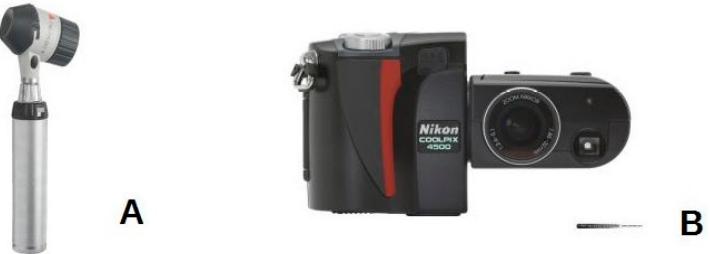
Figure 1. ( A ) Contact dermatoscope HEINE Delta 20T; ( B ) Professional reflex camera NIKON E4500.